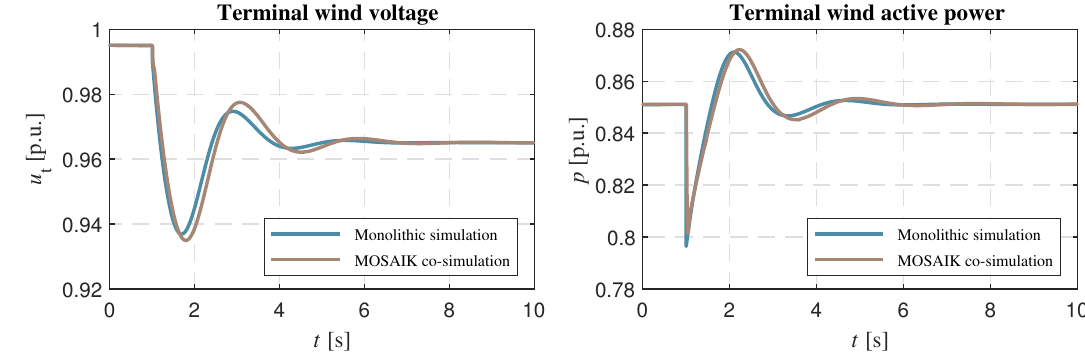
Figure 14. Response of the wind turbine to a step in the voltage set-point.